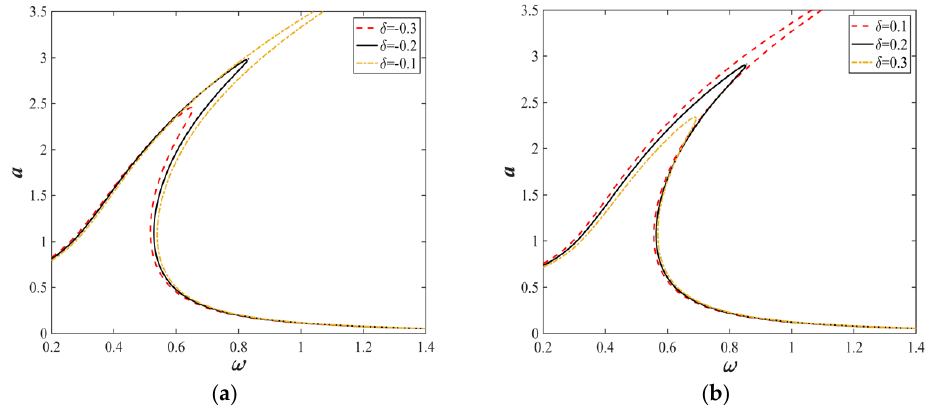
Figure 10. Amplitude and frequency characteristic curves of the system under different δ : ( a ) δ < 0 ; ( b ) δ > 0 .